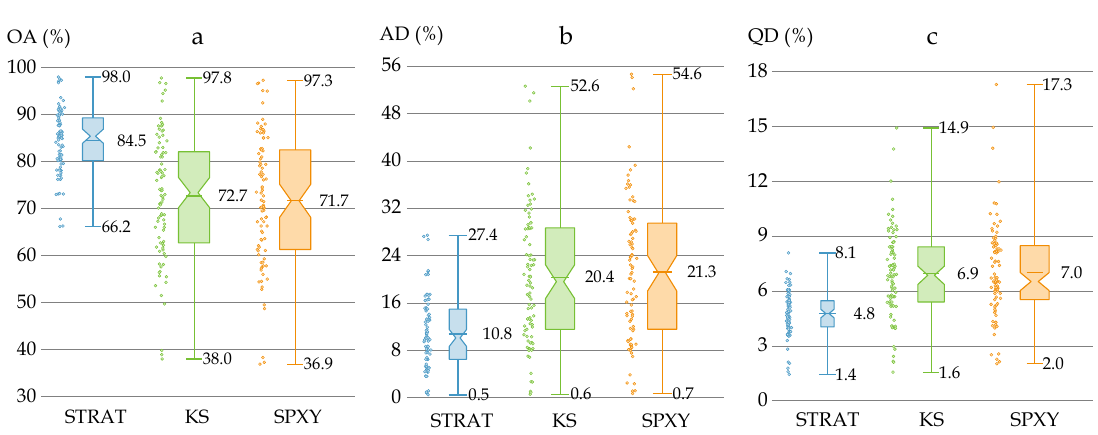
Figure 6. The box plots of the OAs ( a ), ADs ( b ) and QDs ( c ) of the 270 models with the stratified random sampling (STRAT), Kennard-Stone sampling algorithm (KS), and subset partition based on joint X-Y distances (SPXY) methods. Each box has three whisker labels representing the maximum, mean, and minimum values for each dataset from top to bottom. The box width represents SD and a comparatively wider box width indicates a larger SD value.